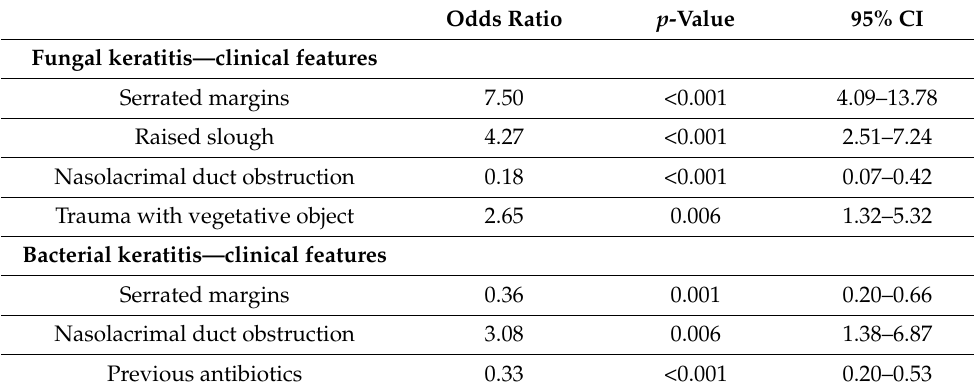
Table 6. Multivariable analysis of clinical features occurring in fungal and bacterial keratitis (mixed infections included).